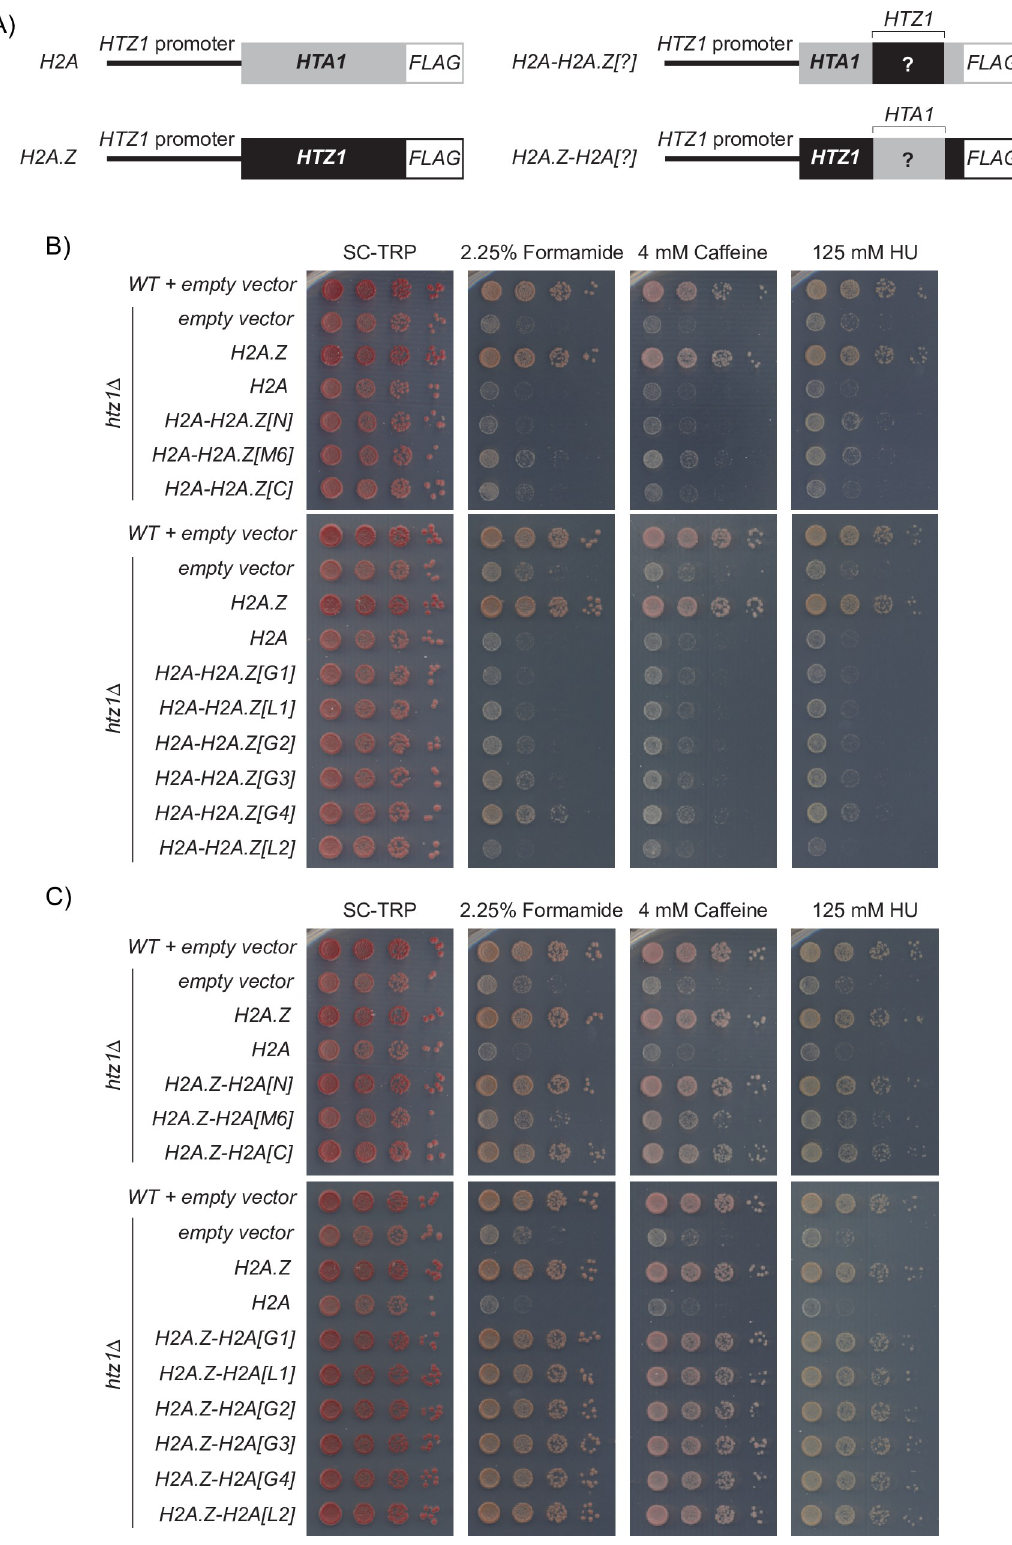
Fig 2. Systematic analysis of regions that diverge between H2A and H2A.Z revealed that the N-terminal, M6, G3, and G4 regions of H2A.Z may contribute to H2A.Z-specific function. (A) H2A.Z ( HTZ1 , black) and H2A ( HTA1 , grey)